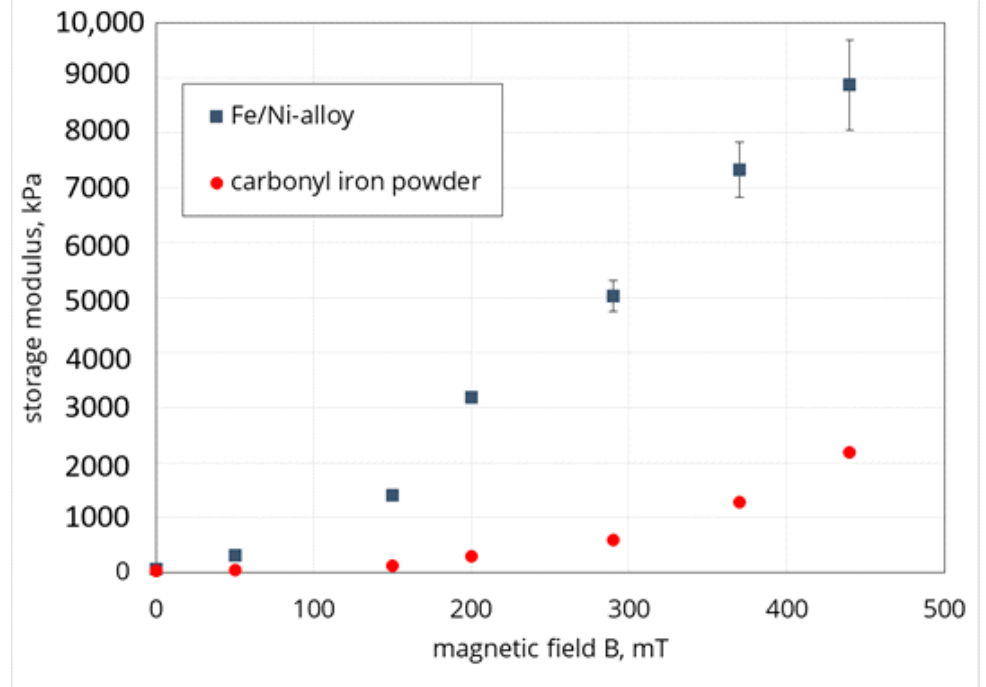
Figure 7. Shear storage modulus of the Fe / Ni alloy and carbonyl iron-based samples as a func-tion of Figure 7. Shear modulus of the Fe/Ni alloy and carbonyl iron-based samples as a function of magnetic magnetic field (at a strain of field (at the strain of 0.00014).